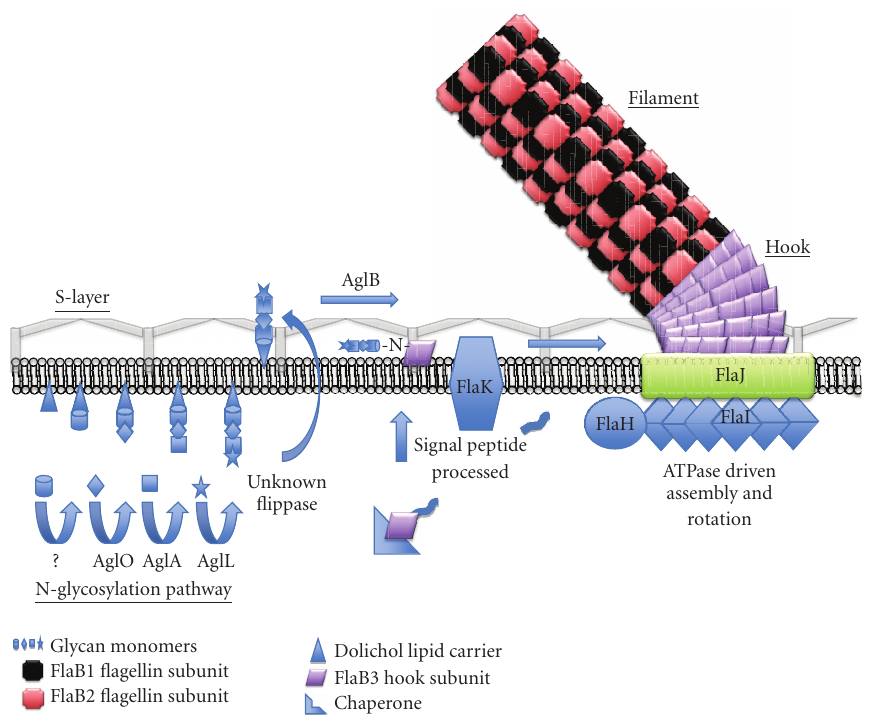
Figure 4: Model of assembly of M. maripaludis flagella, incorporating glycan synthesis and signal peptide removal.